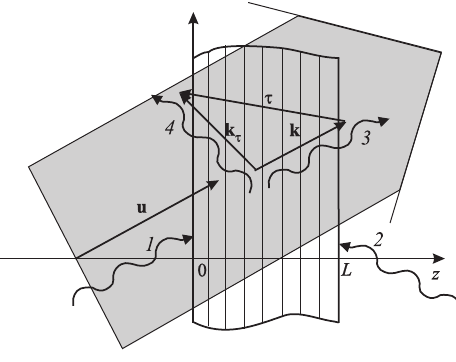
Figure 1. A simple scheme of quasi-Cherenkov VFEL (Bragg